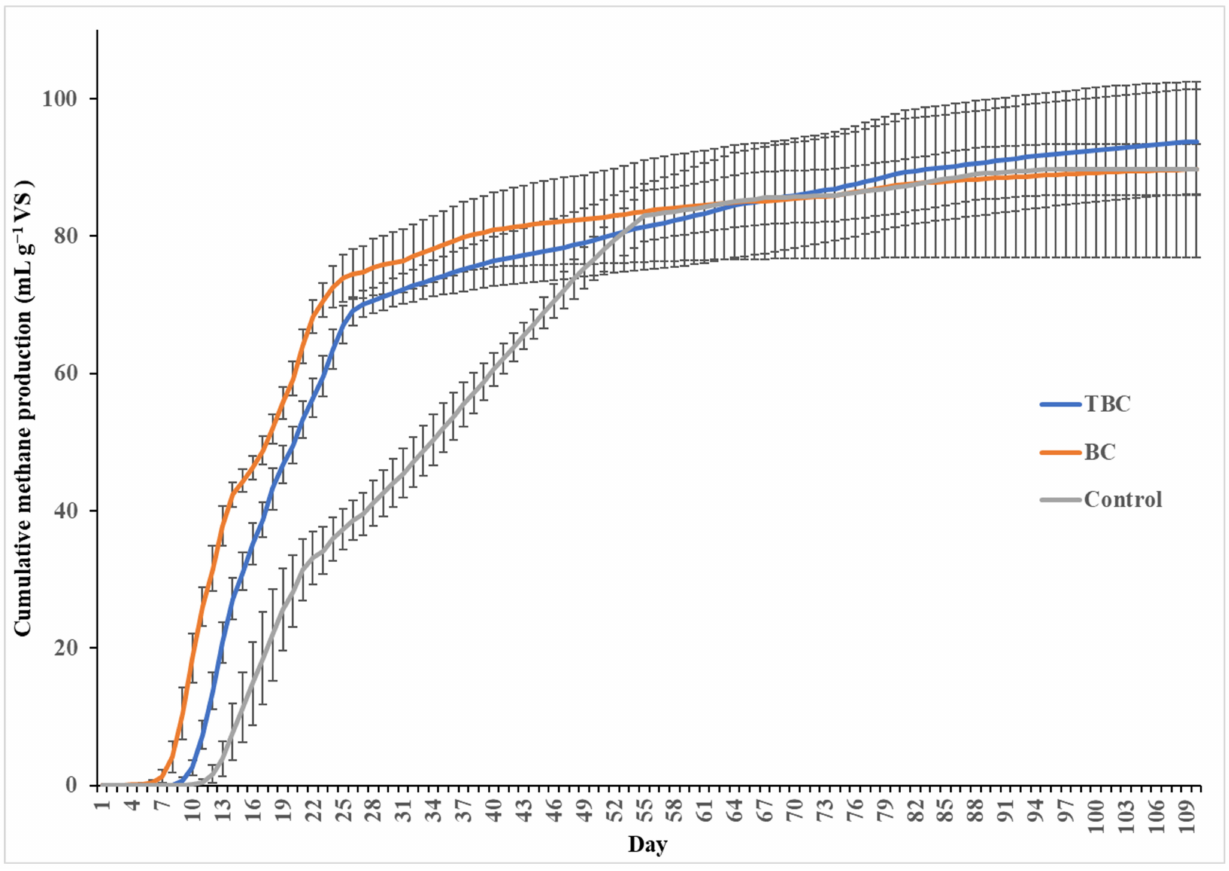
Figure 1. Cumulative CH 4 production (mL g − 1 VS) over 110 days, by acid–alkali-treated biochar (TBC), wood biochar (BC) and no biochar treatments